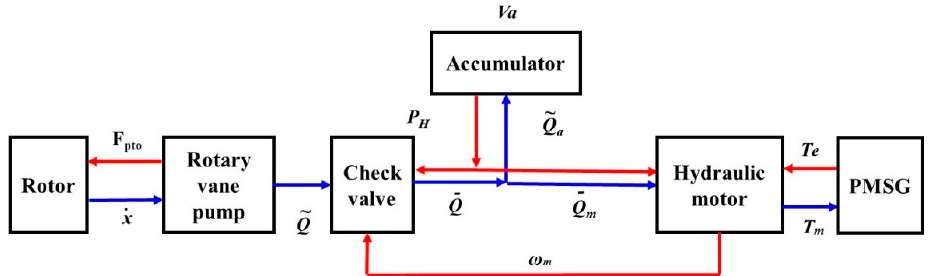
Figure 3. Hydraulic-based PTO system.